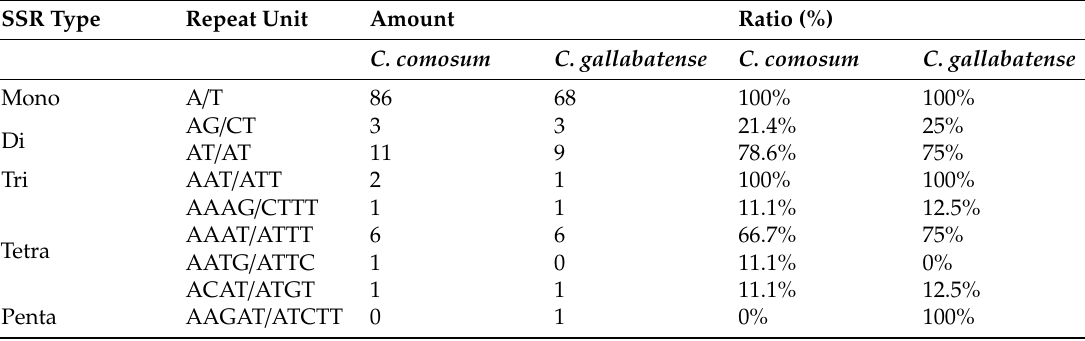
Figure 4. Number of different repeat units of SSRs.